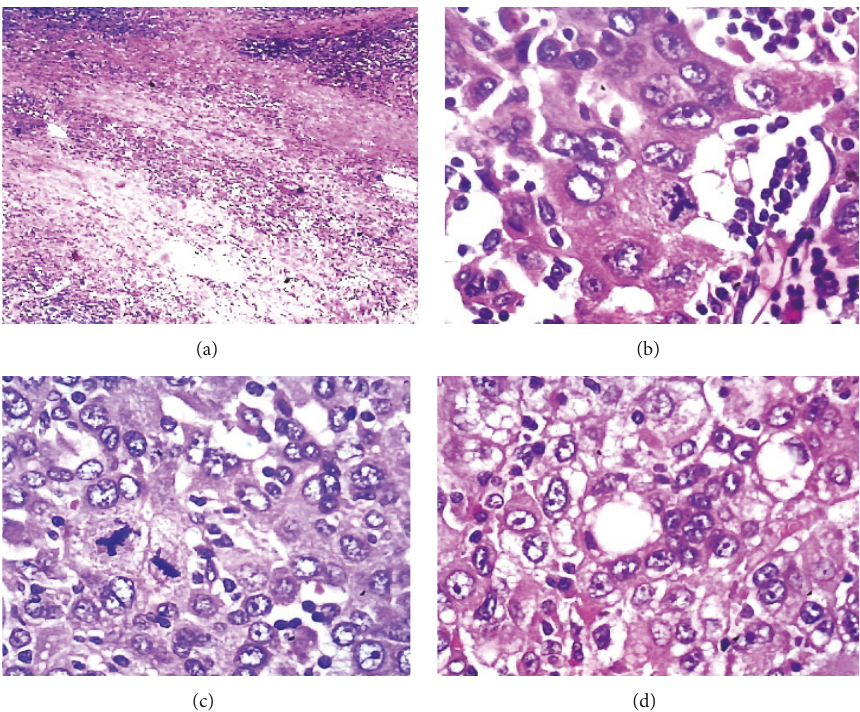
Figure 2: (a) Fibrous band delimiting nodular area ( HE 40x ); (b) globular-polyhedral epithelial elements, with a pink, foliaceus, cytoplasm ( HE 200x ); (c) high mitotic activity, atypical mitotic figures ( HE 200x ); (d) trabecular arrangement with acinar formation ( HE 200x ).